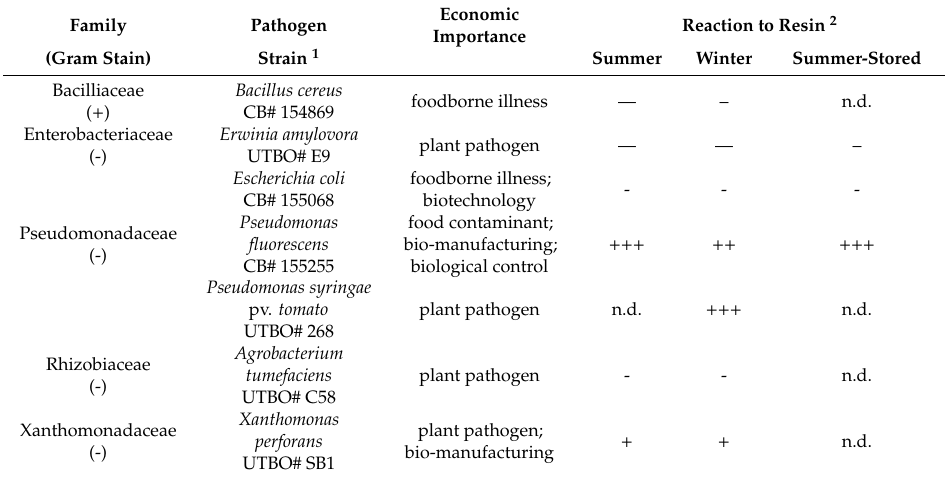
Figure 2. Gas Chromatography (GC) profiles of lyophilized Sciadopitys verticillata resin: ( A ) Resin collected in summer and stored at − 20 °C for 6 months before evaluation, ( B ) Resin collected in winter and evaluated within 72 h. Compounds with peaks greater than 1% of total peak area: 1 = tricyclene; 2 = 1R- α -Pinene; 3 = β -Pinene; 4 = D-Limonene; and 5 = β -Elemene. Table 2. E ff ect of Sciadopitys verticillata resin on populations of tested